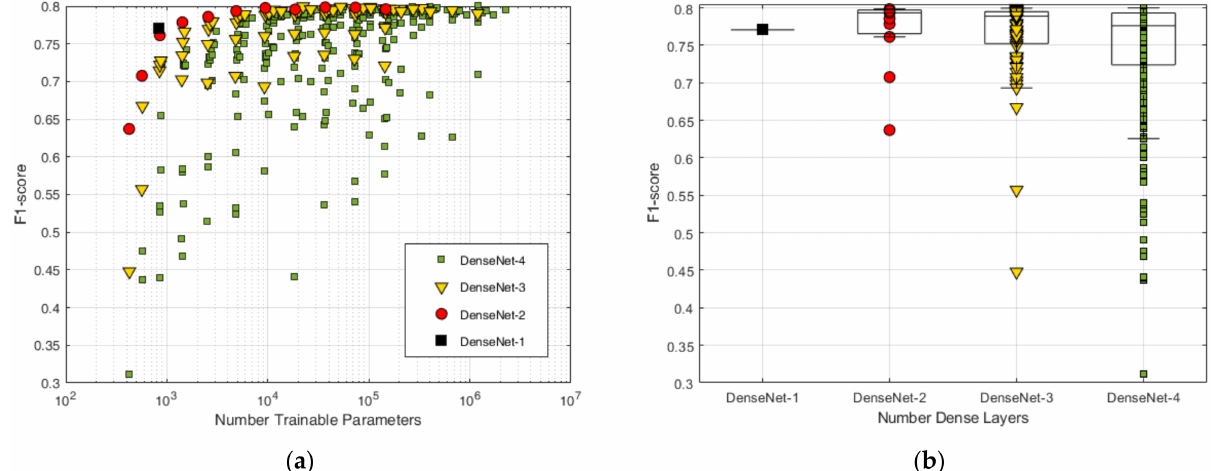
Figure 3. Performance of all DenseNet architectures in the grid search, grouped to the number of dense layers: ( a ) F1 (Total) score observations in respect to the number of trainable parameters; ( b ) Statistical distributions of F1 (Total) score, showing the median value (line), interquartile range 25–75% (boxes), non-outlier range (whiskers) and individual observations (markers).